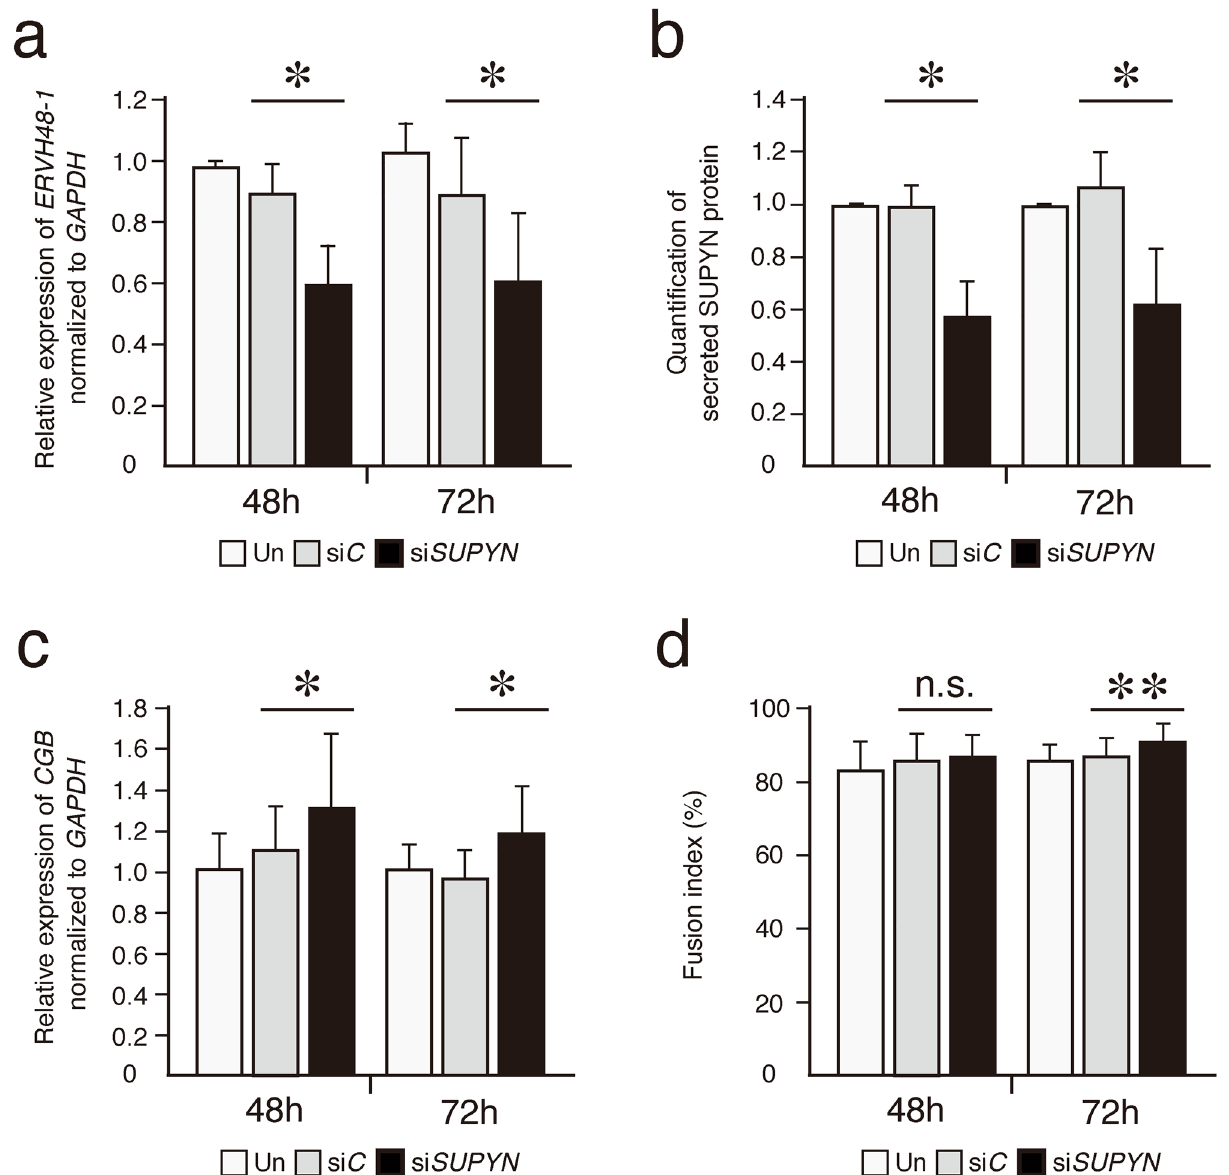
Figure 5. SUPYN knock-down increases CGB gene expression in TS21 primary cells. SUPYN -specific mRNA knock-down in TS21 primary cells using a siRNA (si SUPYN ) or control siRNA (si C ). ( a ) Quantitative RT-PCR results of ERVH48-1 transcripts. ( b ) Secreted SUPYN protein in siRNA-treated and untreated cells. SUPYN protein levels in primary trophoblast cell culture supernatants were quantified by a SUPYN-specific ELISA (ng/ml). Quantification was normalized to untreated samples cultured for similar time periods (48 or 72H) ( c ) SUPYN knock-down induced an increase in CGB gene expression. Expression is normalized to untreated samples cultured for similar time periods (48 or 72H). ( d ) The number of nuclei in SUPYN-expressing cells was counted and fusion indices were calculated. Experiments were performed using four independent samples with 5 independent microscopic fields evaluated for each sample. Values represent mean ± SD (n = 4). Statistical significance was set at * p < 0.05 and ** p < 0.01 compared to matched scrambled siRNA-treated samples using Mann–Whitney U-test. n.s. : not